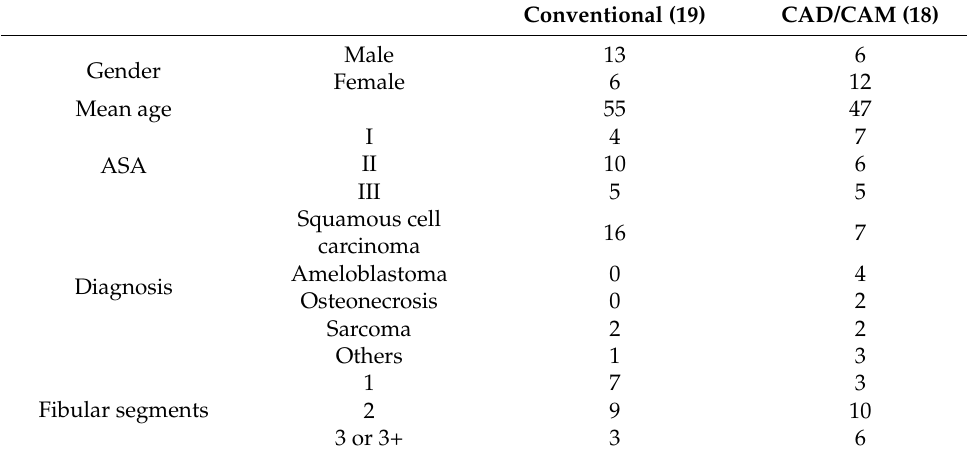
Table 1. Demographic